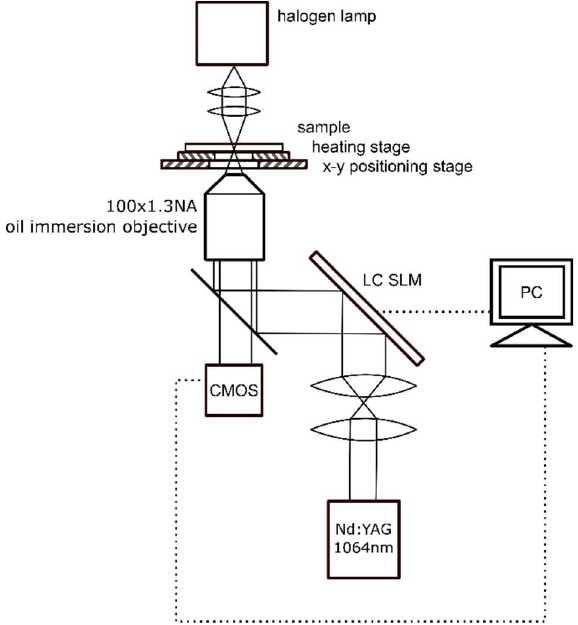
Figure 4. Schematic of the holographic optical tweezers setup.